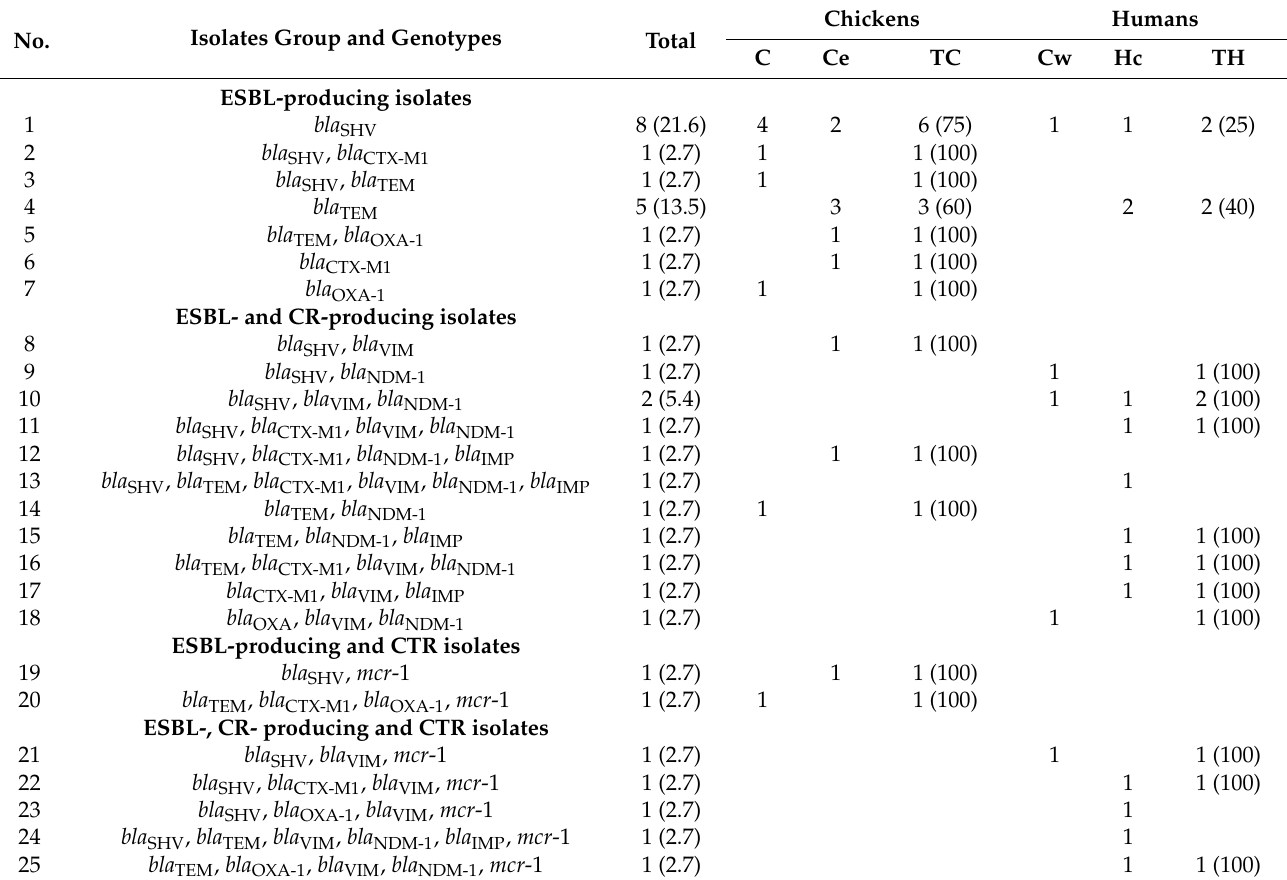
Table 3. Distribution of extended-spectrum β -lactamase, carbapenemase genes and colistin resistance determinant mcr -1 among 37 K. pneumoniae isolates from chickens and